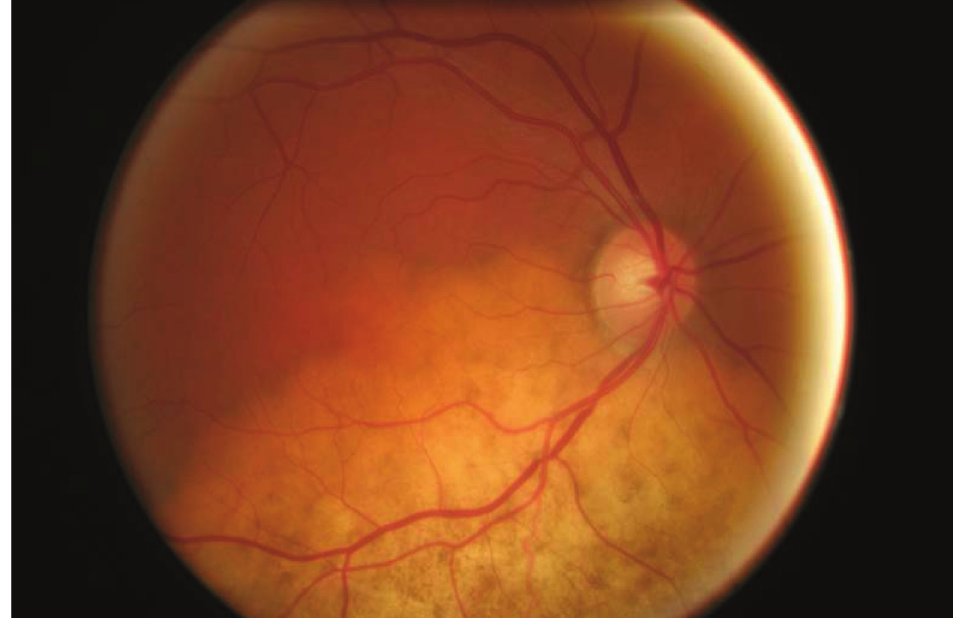
Figure 2: Colour fundus photograph of right eye in May 2007 showing an extensive area of retinal pallor in the inferior macular with areas of altered pigmentation of the